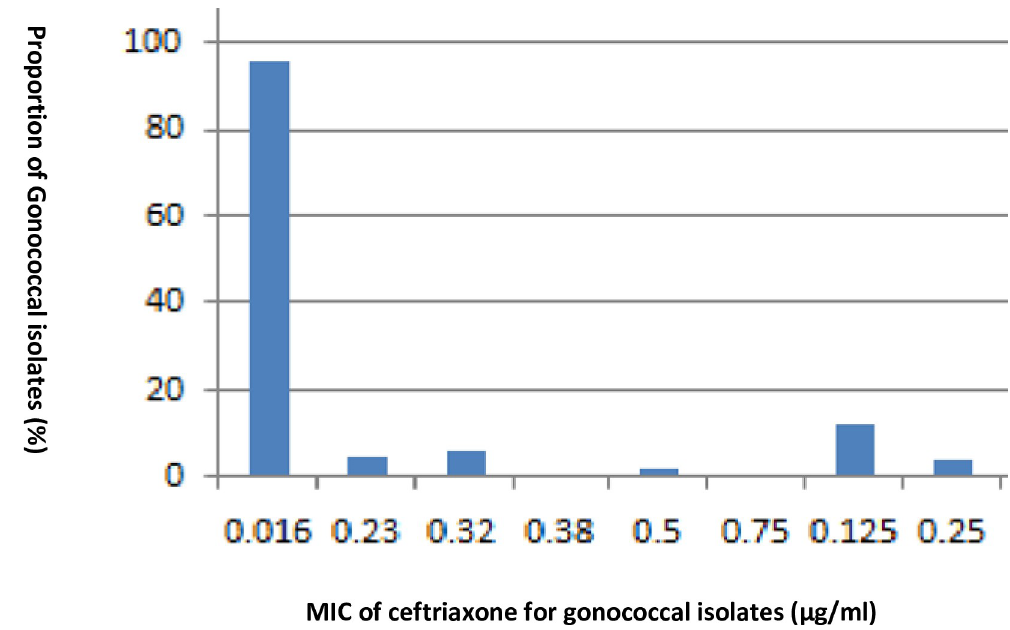
Fig 1. Minimum Inhibitory Concentration (MIC) of ceftriaxone against N . gonorrhoeae